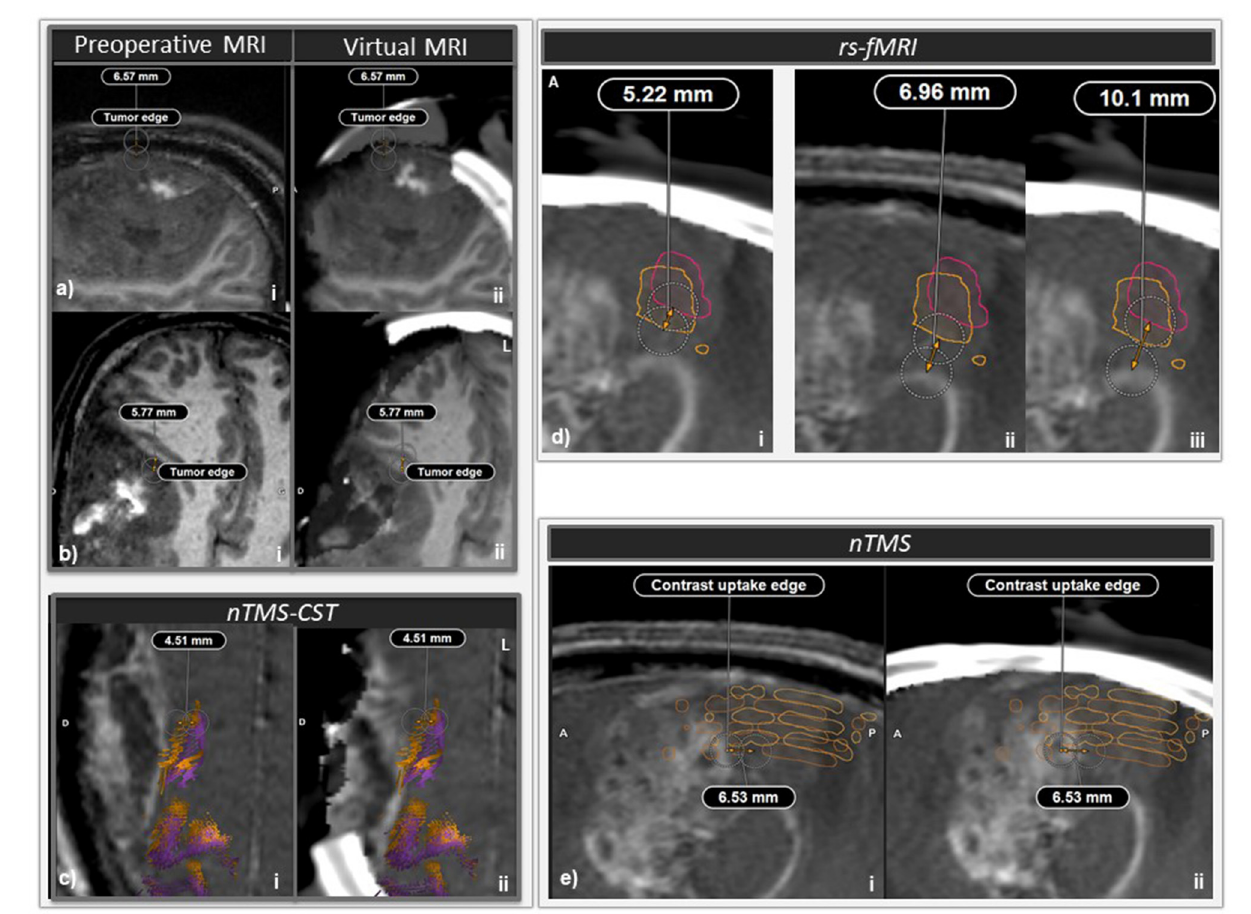
FIGURE 3 | Intraoperative brain imaging and brain shift correction (BSC). (a) First intraoperative brain CT (iCT) acquisition and BSC, just after dura mater opening. i: sagittal slice of pre-operative magnetic resonance imaging (MRI), ii: sagittal slice of iCT and elastically transformed pre-operative MRI (virtual MRI) superimposed and coregistered with i. A significant tumor bulge occurred through the craniotomy and a brain shift of 6.57mm could be measured at some location. (b) Second iCT acquisition with BSC halfway through surgery. i: Axial slice of preoperative MRI, ii: axial slice of iCT with virtual MRI. A 5.77mm brain shift was measured at the level of the anteromedial edge of the tumor. (c) nTMS-guided corticospinal tract (nTMS-CST) comparison before (orange tracts) and after (purple tracts) BSC. i: Axial slice of preoperative MRI, ii: axial slice of second iCT acquisition with virtual MRI. At some location a 4.51mm shift was measured between preoperative nTMS-MT before and after BSC. (d) Comparison of rs-fMRI ROIs before (orange outline) and after (pink outline) BSC. i and iii: sagittal slice of second iCT acquisition with virtual MRI, ii: sagittal slice of pre-operative MRI. At some location, a 5.22mm shift was measured between preoperative rs-fMRI ROIs before and after BSC (i). At some location, the minimal distance between tumoral border and the preoperative rs-fMRI ROI shifted from 6.96mm (ii) to 10.1mm after BSC (iii). (e) Sagittal slice of pre-operative MRI (i) and second iCT acquisition with virtual MRI (ii). At some location, a 6.53mm shift could be measured at some location chosen on the contrast uptake edge of the posterior aspect of the tumor between preoperative MRI and second iCT with virtual MRI. After elastic fusion and virtual MRI, nTMS positive ROIs shifted posteriorly relatively to the tumor.